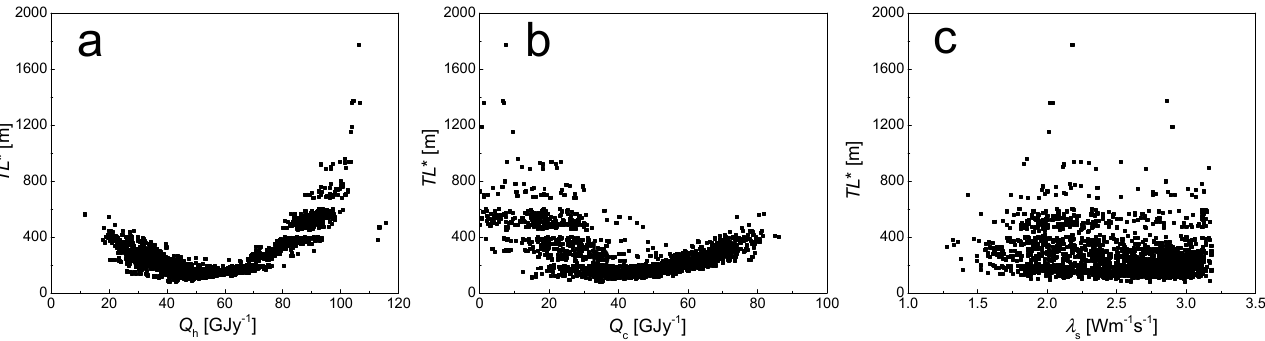
Figure 8. Plots of simulated required total lengths of BHEs with heating ( a ), cooling ( b ) loads and ground thermal conductivity ( c ).